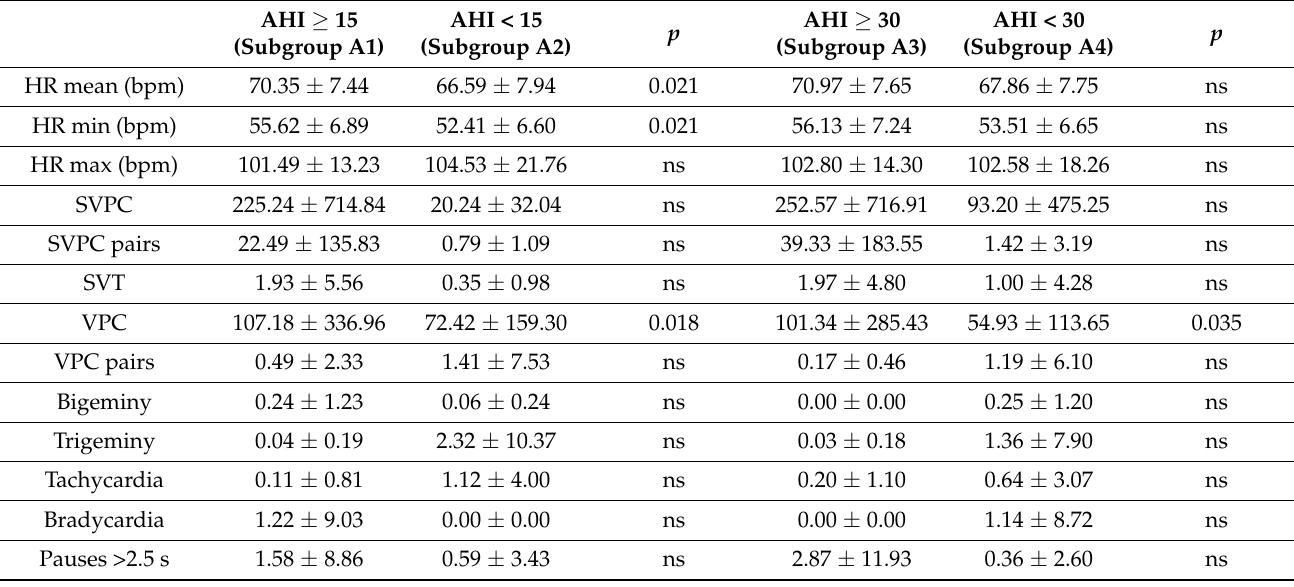
Table 4. Quantitative parameters of 24-h ECG Holter monitoring in the studied subgroups of patients divided by AHI threshold